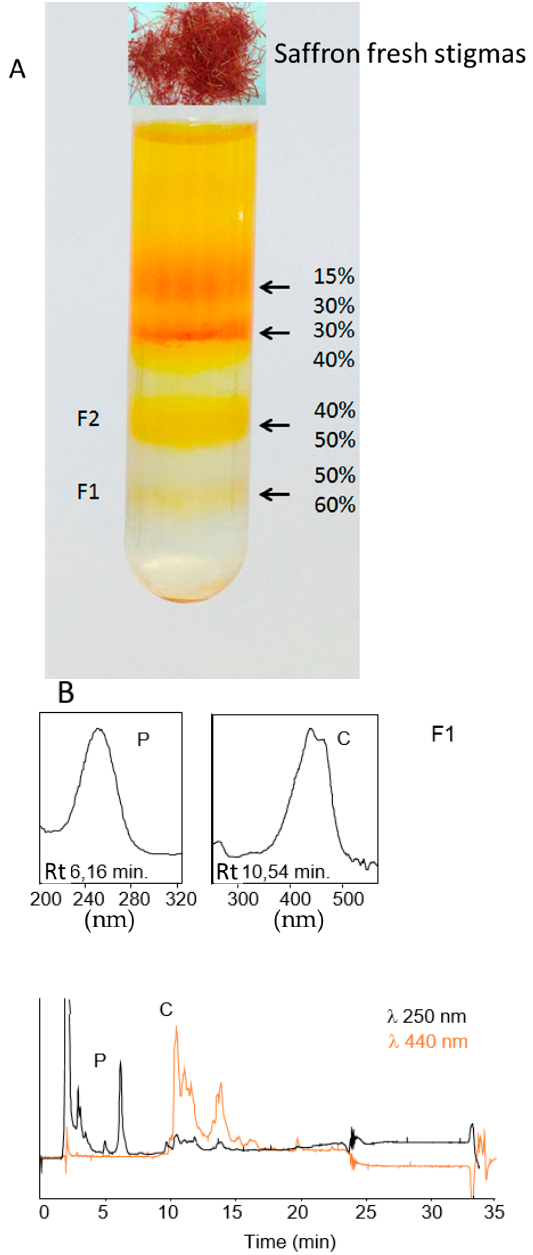
Figure 4. ( A ) Pattern of bands obtained after sucrose density gradient from saffron fresh stigmas; and ( B ) HPLC DAD chromatograms showing the presence of crocins in fraction F1.